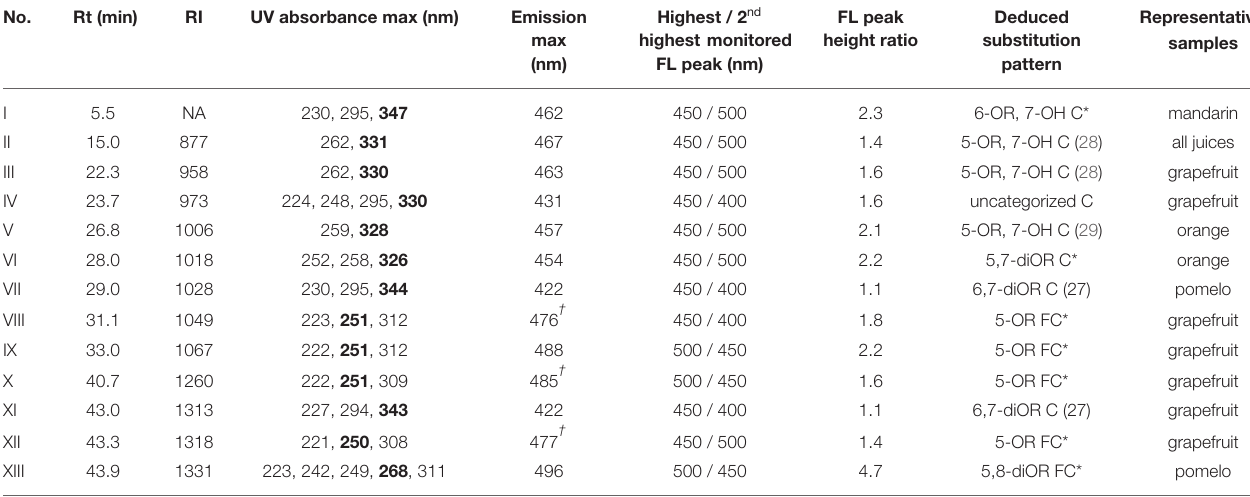
TABLE 1 | Retention index, UV and fluorescence spectral maxima, and fluorescence peak height ratios of the 13 tentatively identified OHAs. No. Rt (min) RI UV absorbance max (nm) Emission